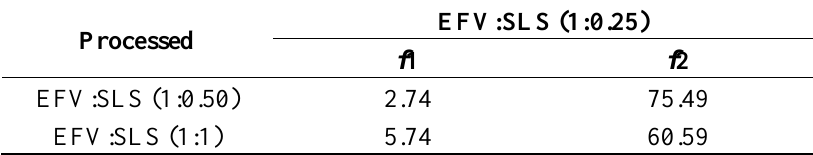
Table 4. Values of f 1 and f 2 found for EFV:SLS processed samples.